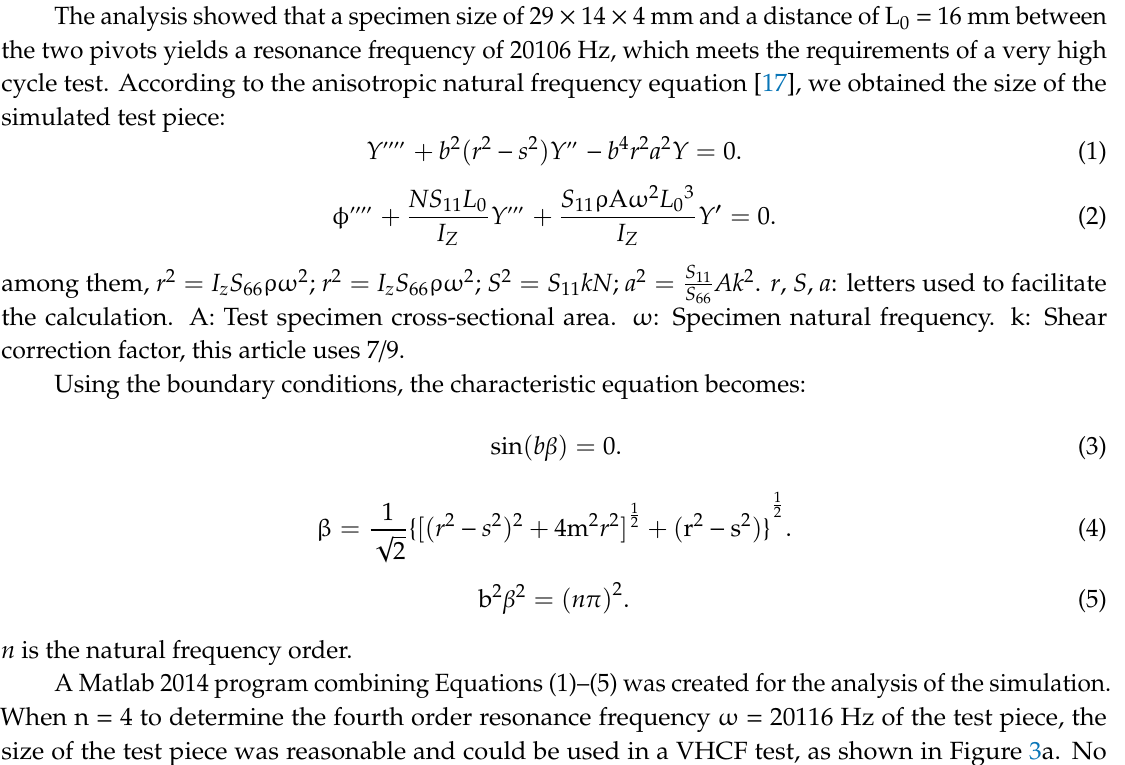
Figure 2. ( a ) Displacement and ( b ) stress simulation results for the CFRP specimens.